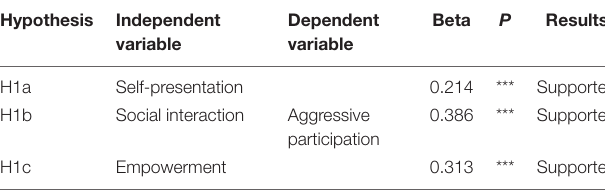
TABLE 2 | Path coefficients and verification results for Study